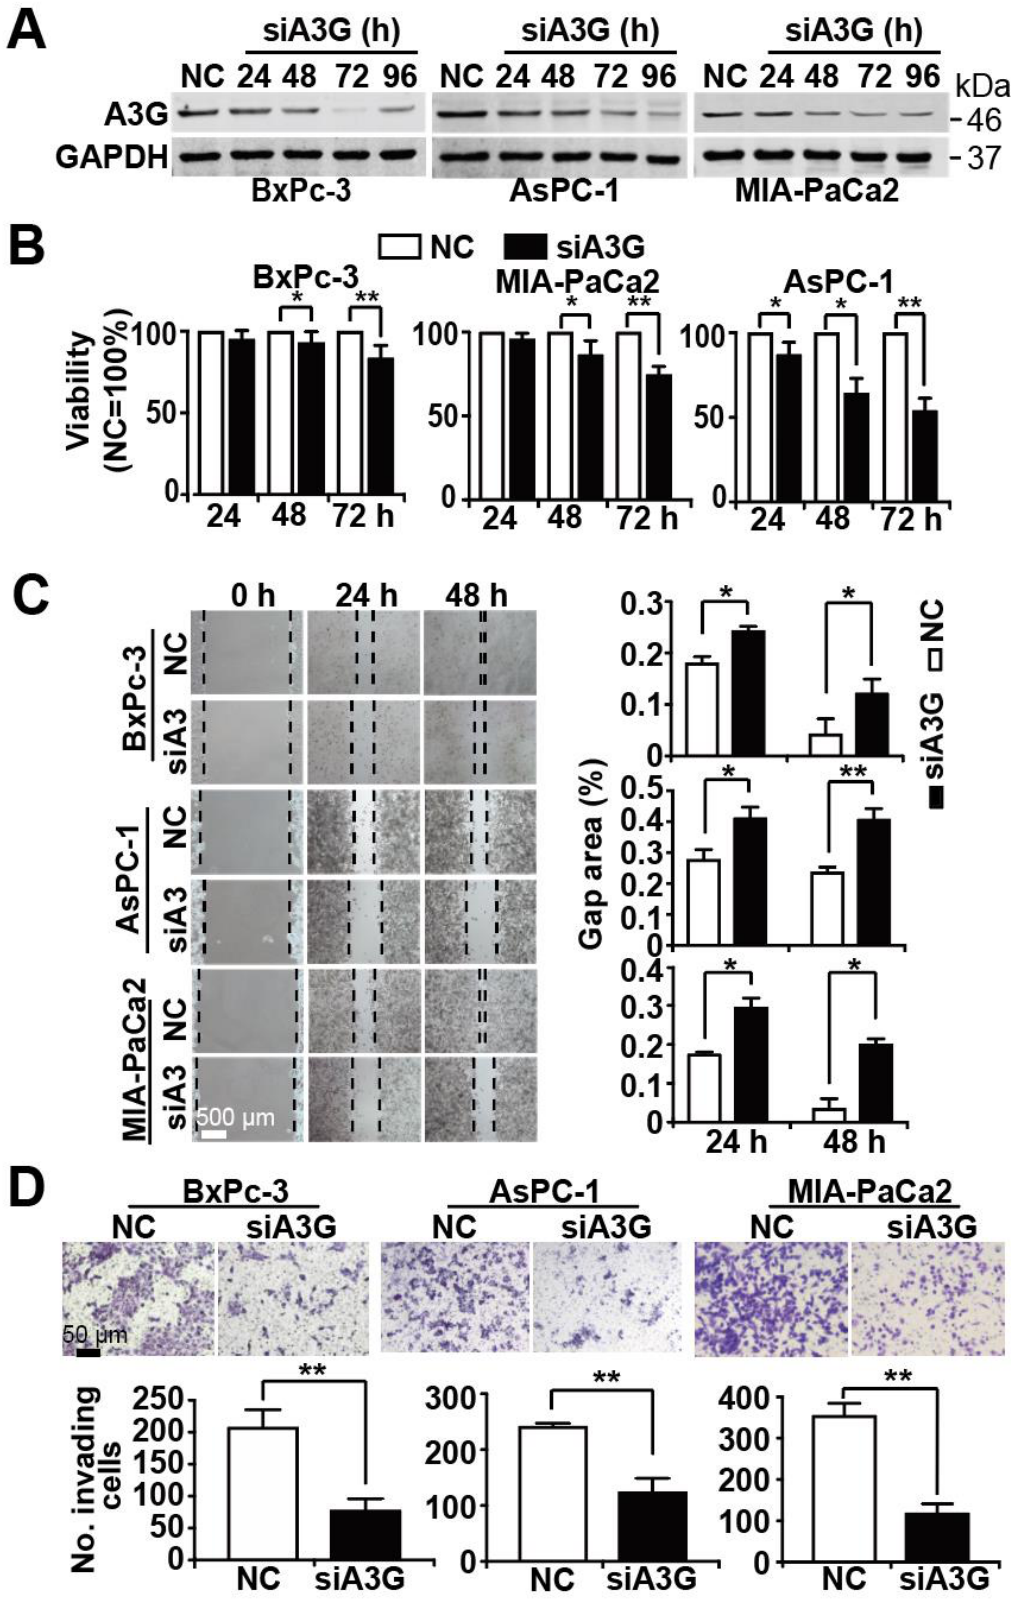
Figure 5. Knockdown of APOBEC3G inhibits progression features. BxPc-3, AsPC-1 and MIA-PaCa2 cell lines were lipotransfected with NC or siA3G at 20 µ g each. ( A ) Proteins were harvested 24 h, 48 h, 72 h, or 96 h later, and the